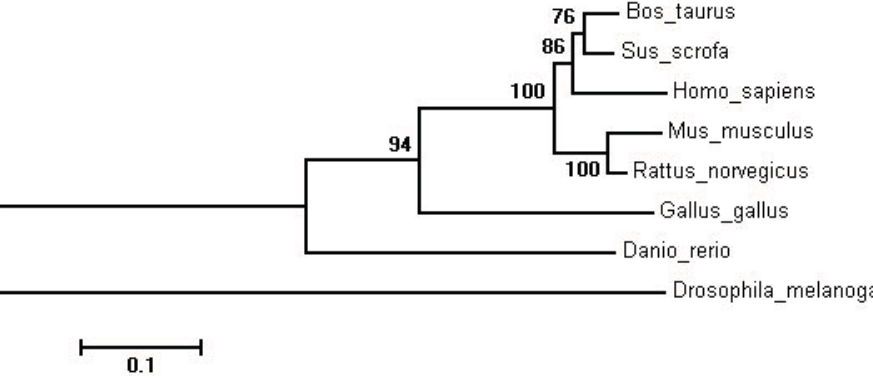
Figure 1. Phylogenetic tree of the SIRT2 gene in different